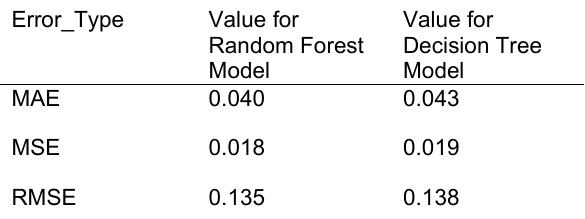
Table 2. Values of MAE, MSE, RMSE for overall data